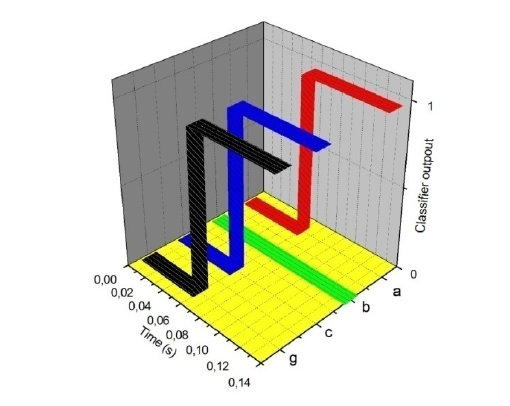
The fault classi(cid:28)er indicates that the phases "b" and "c" are always zero, which implies that it is a single-phase fault (a-g). The fault is clas- si(cid:28)ed on phase "a" at time 0.062 sec. and on the ground at time 0.063 sec, so the fault classi(cid:28)ca- tion time is equal to 0.063 sec, it’s late by 3 ms. Fig. 7 represents the fault classi(cid:28)er output as a function of time for a double-phase fault with- out ground (a-b). Fig. 8 represents the fault classi(cid:28)er output as a function of time for a double-phase fault with- ground (a-c-g).